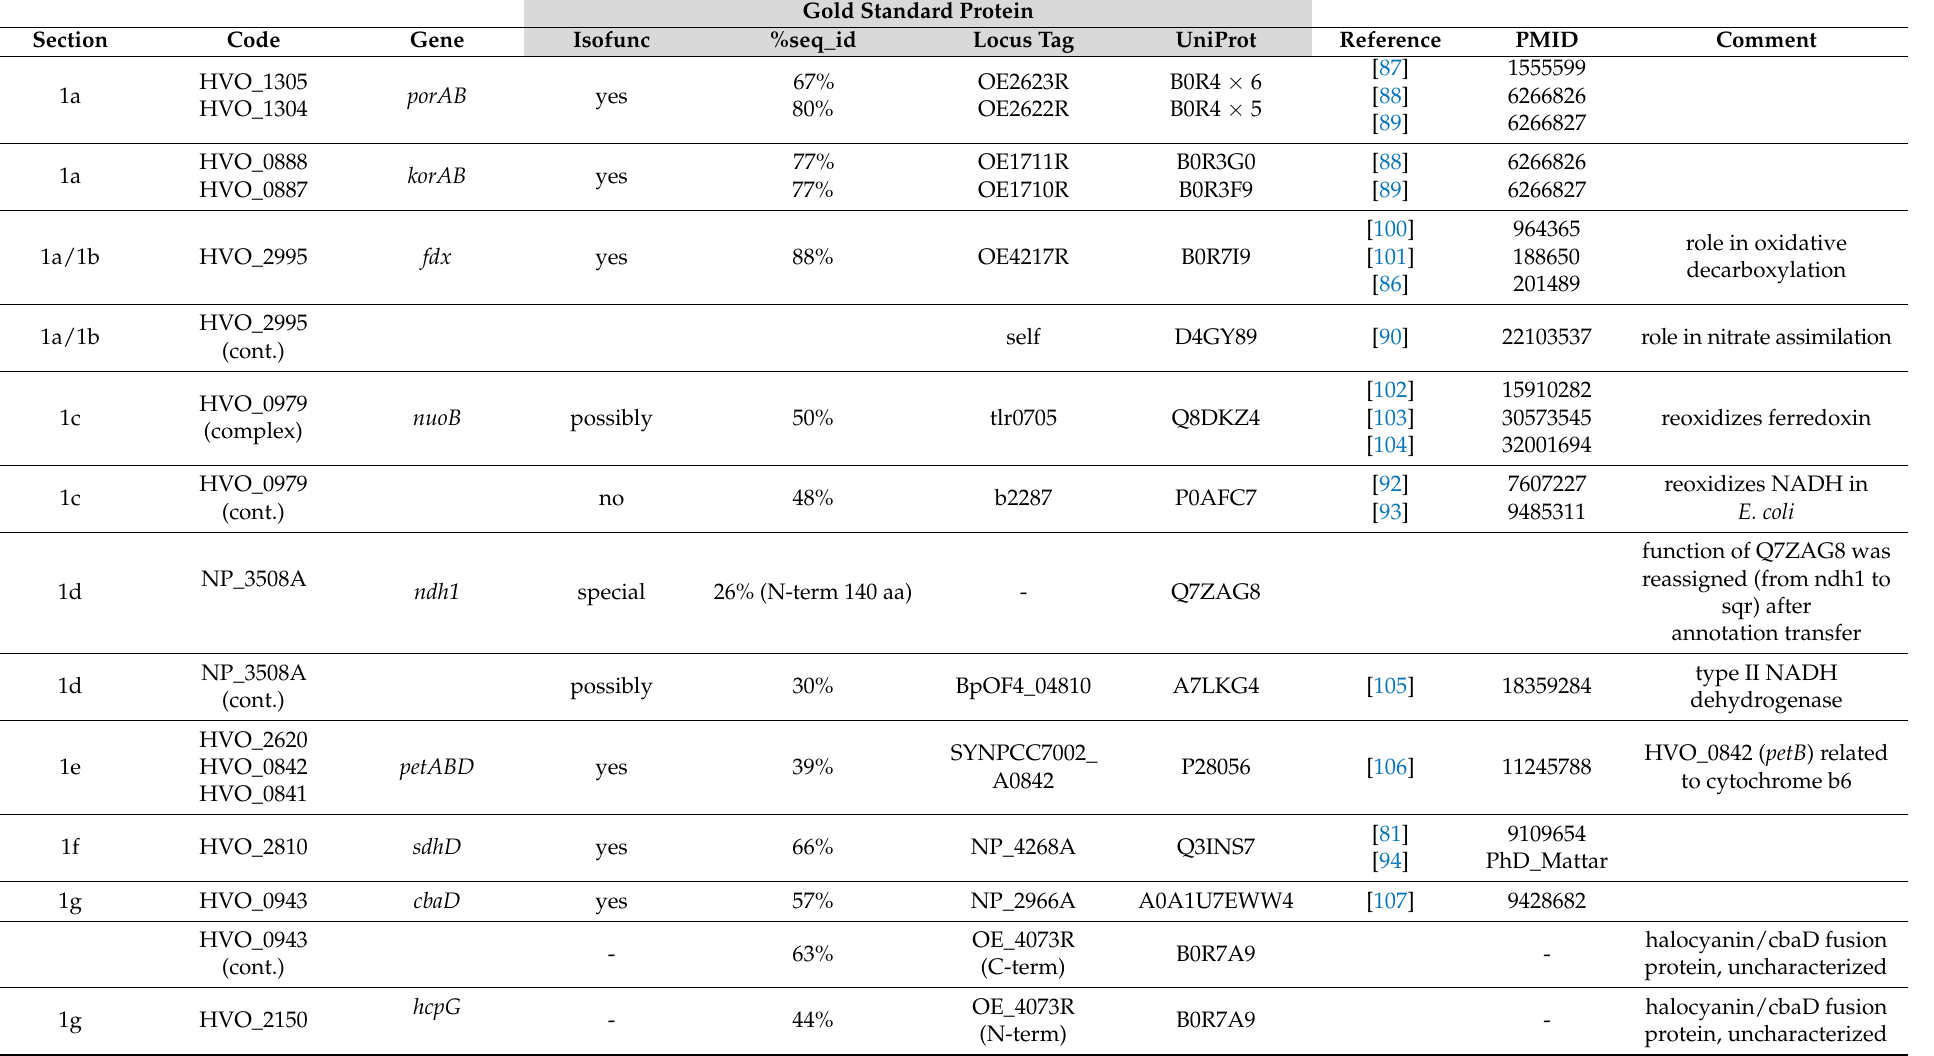
Table 1. Proteins with open annotation issues and their Gold Standard Protein homologs (Section